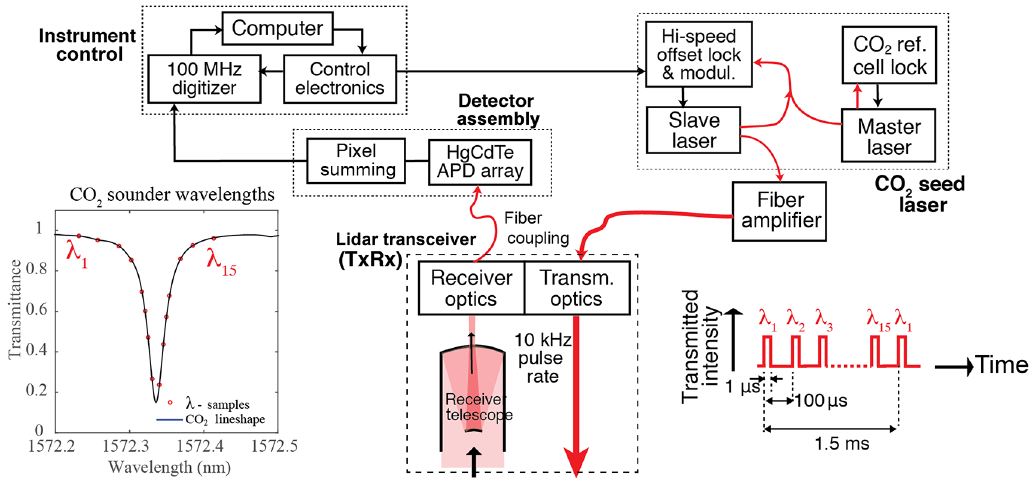
Figure 2. Instrument block diagram for the 2014 and 2016 versions of the CO 2 Sounder lidar described here. The inset on the right shows the transmitted pulse train sequence that is repetitively stepped in wavelength across the CO 2